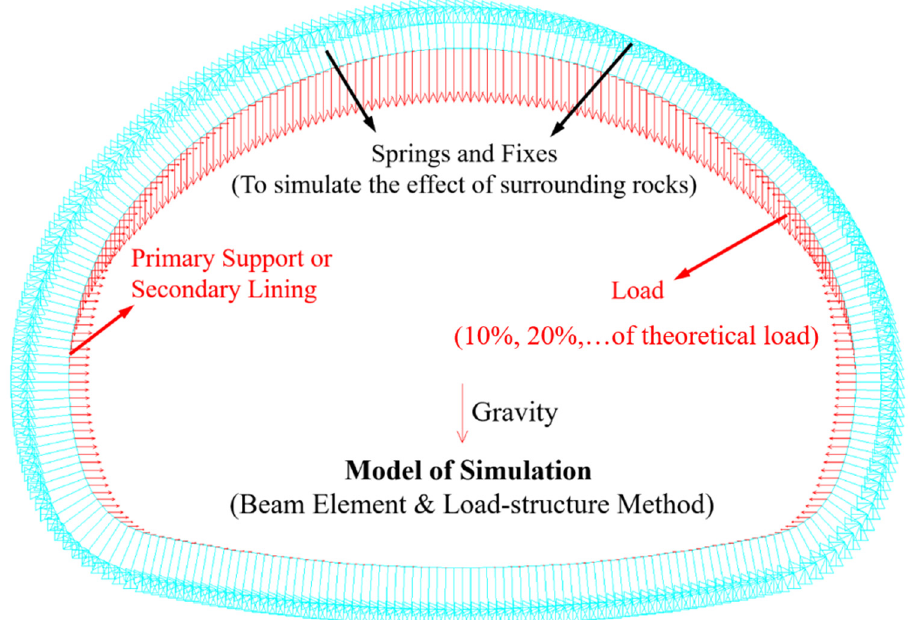
Figure 4. The finite-element model of simulation. It is a load-structure model and mainly simulated by beam elements and springs.